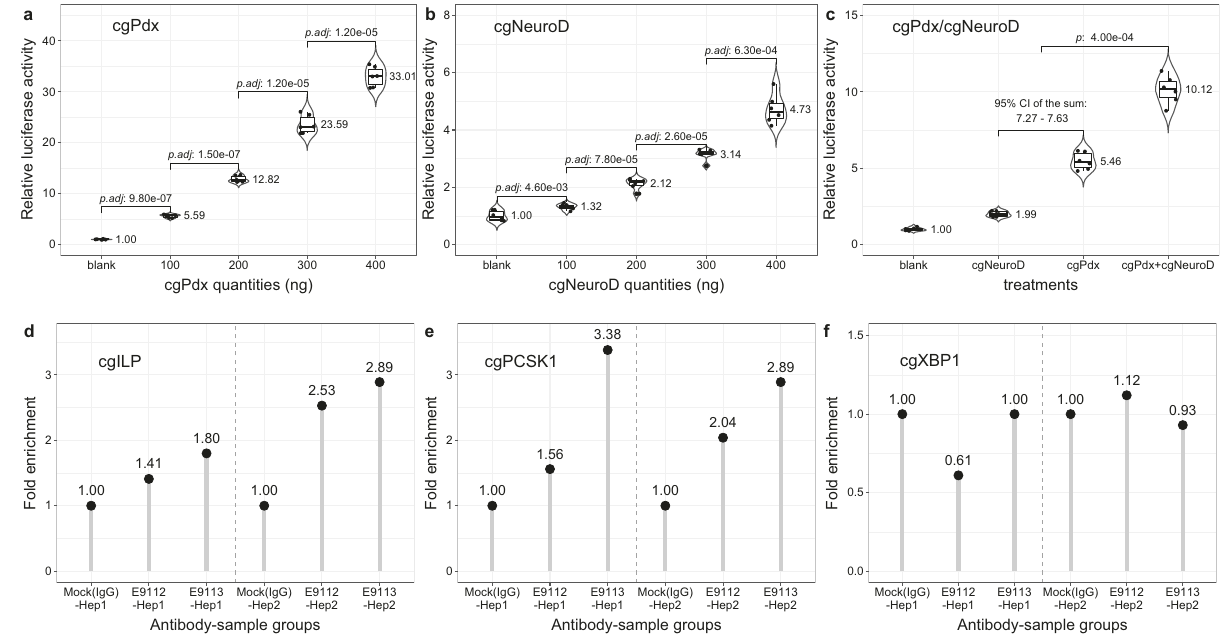
Fig. 5 Transcriptional activity of oyster cgPdx and cgNeuroD in cell culture and oyster hepatopancreas tissue. a Transcriptional activity of oyster cgPdx on cgILP B1 element in COS7 cells demonstrating dose-dependent induction of luciferase reporter gene expression. Points show values of each individual assay. Violin and box plots are used to show the distribution of the data, with the mean at the right side. p values of comparisons (two-sided t -test) between adjacent groups are shown. b Transcriptional activity of cgNeuroD on cgILP B1 element in COS7 cells showing a similar but weaker dose-dependent induction effect. c Co-transfection of cgPdx and cgNeuroD gives higher transcriptional activity than the sum of the individual activities, suggesting functional synergy between cgPdx and cgNeuroD proteins. 150 ng of cgPdx and cgNeuroD plasmids was used for group (cgPdx + cgNeuroD). The pool of all the possible sums of individual relative luciferase values between cgNeuroD and cgPdx groups was used to estimate the 95% con fi dence interval (CI) of the activity sum. Signi fi cance of difference between group (cgPdx + cgNeuroD) and the sum of cgNeuroD and cgPdx groups was calculated by bootstrapping ( n = 100,000). For experiments in a – c , n = 3 biologically independent cells by two technically independent measurements. Box represents a range from the fi rst to the third quartile while whisker shows the minimum and maximum values. The line in each box shows the median. Relative luciferase activity in the cells transfected with blank pSI and the reporter plasmid is set at 1.00. p values were calculated by two tailed Student ’ s t test and Holm ’ s method to correct for multiple comparisons ( p.adj ). d – f ChIP-qPCR assays on predicted cgPdx binding sites upstream of three putative Pdx target genes in oyster ( cgILP , cgPCSK1 , and cgXBP1 ). Two anti-cgPdx polyclonal antibodies (E9112 and E9113) were used to assay two oyster hepatopancreas samples (Hep1 and Hep2). Source data are provided as a Source Data fi